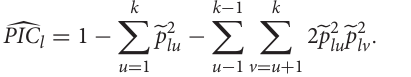
Frontiers in Plant Science |